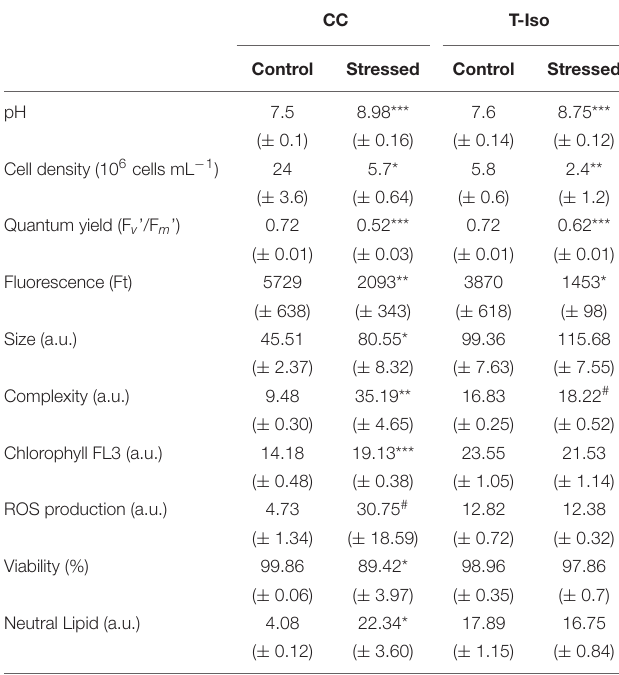
TABLE 1 | Algal health parameters of Chaetoceros calcitrans (CC) and Tisochrysis lutea (T-Iso) cultures which had been ‘stressed’ under high pH conditions or, were non-stressed (Control) before feeding to oyster